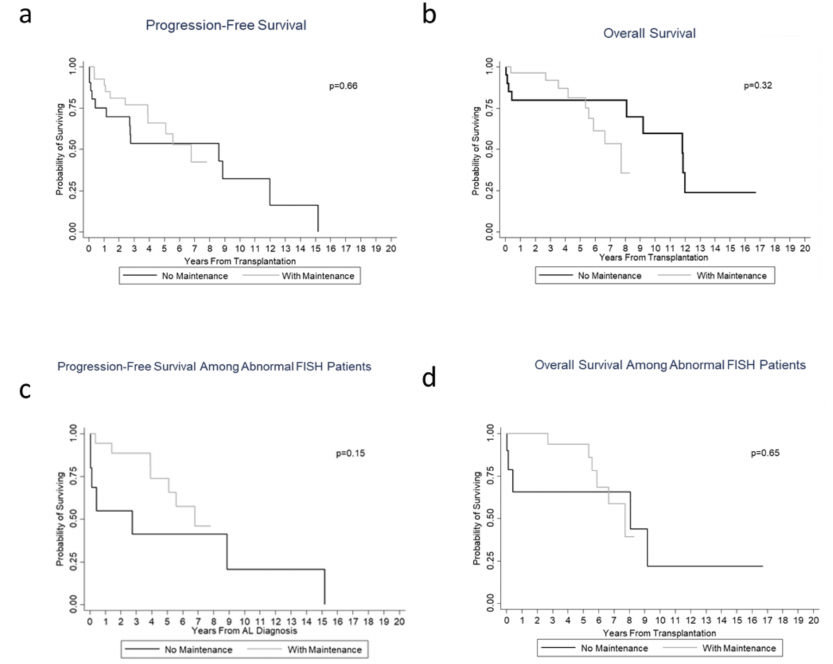
Figure1. Kaplan–Meiercurvesdemonstratingsurvivalmeasuredfrommaintenance( a